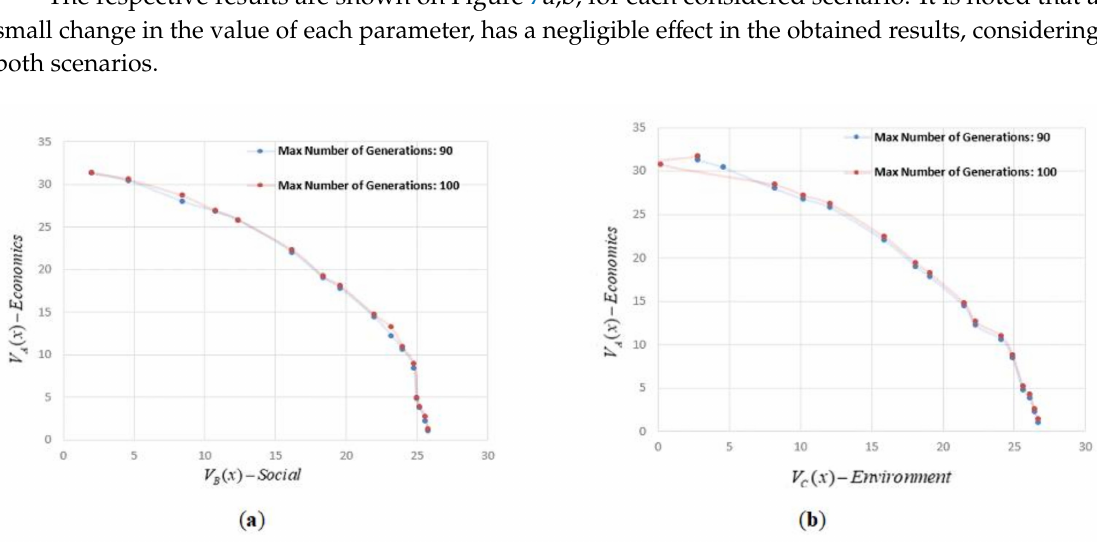
Figure 6. Pareto frontier regarding the 80th and 90th generations. ( a ) ( ω A = 0.65; ω B = 0.35; ω C = 0.00);